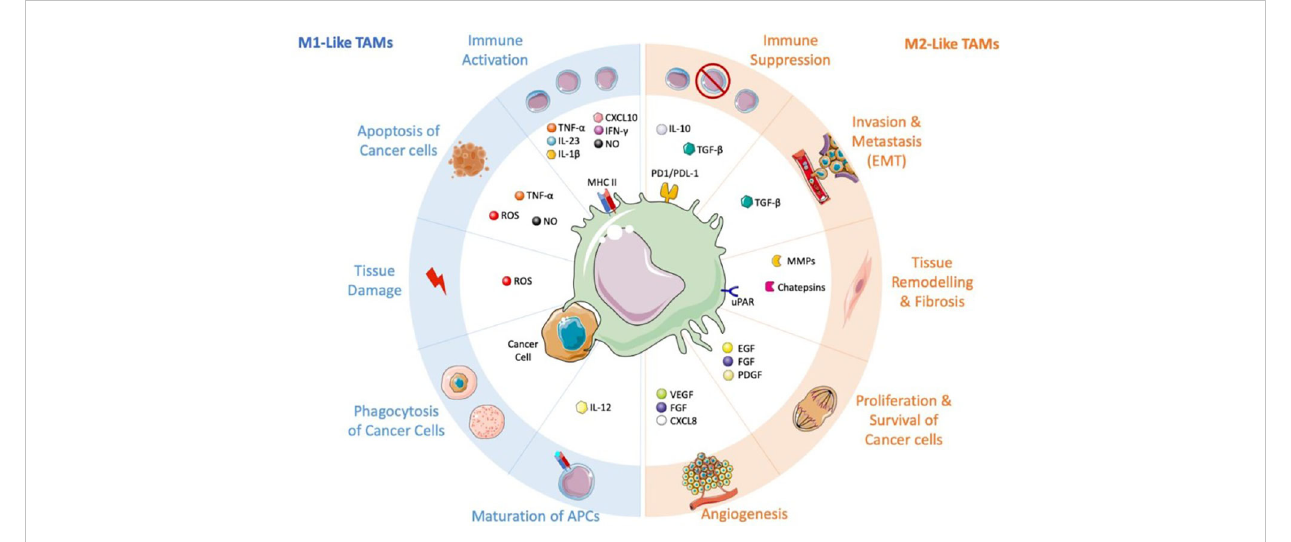
FIGURE 2 TAMs and their con fl icting in fl uence on the tumor microenvironment. this fi gure was reproduced under common creative license